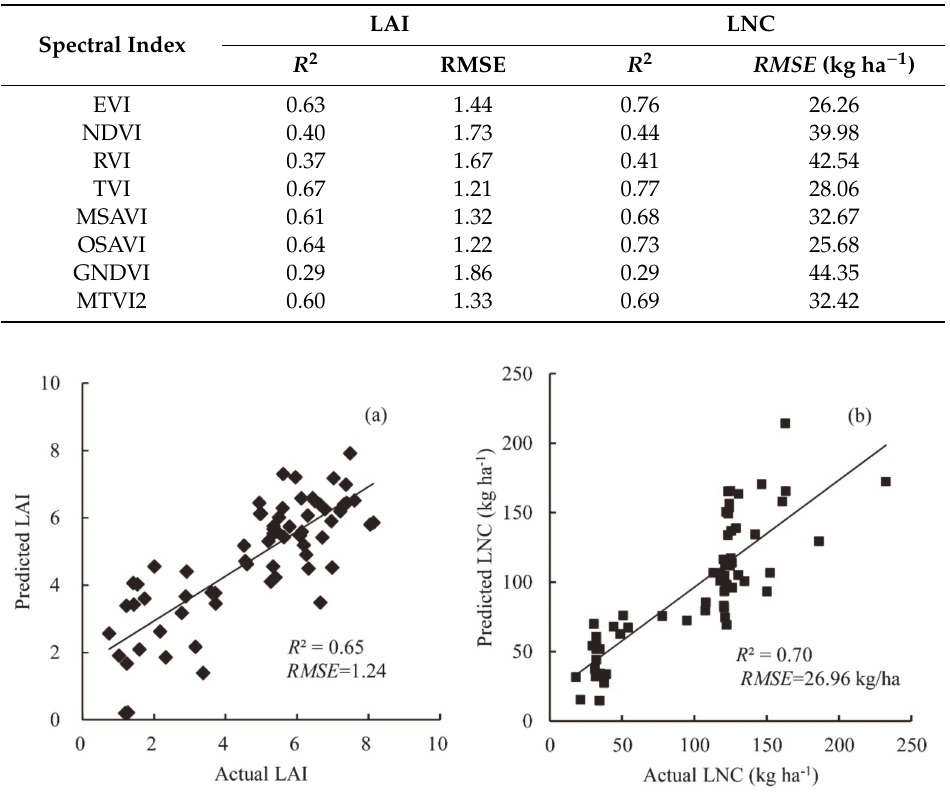
Figure 6. Cross-validation results for the ( a ) LAI model designed by TVI; and ( b ) LNC model designed by